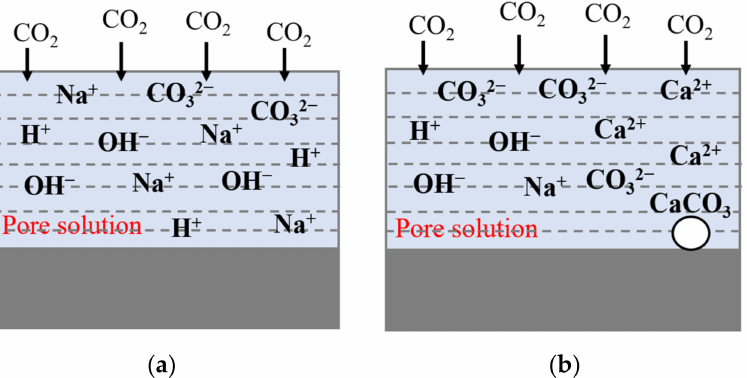
Figure 1. Carbonization process of geopolymers. ( a ) Geopolymers with low calcium content; ( b ) Geopolymers with high calcium content.